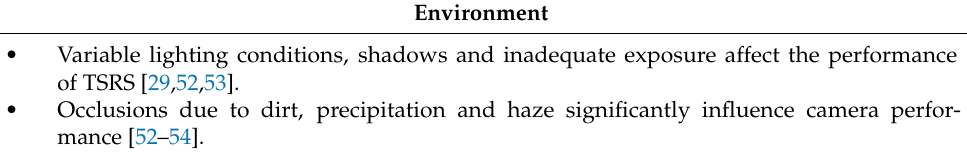
Table 5. Factors limiting traffic sign